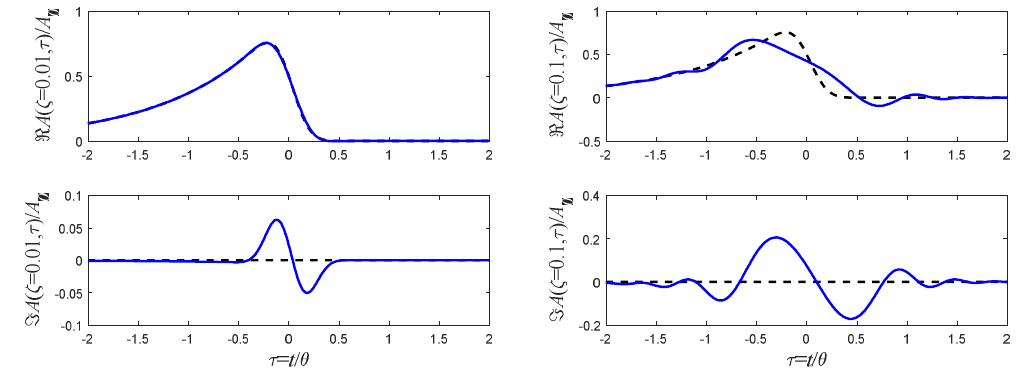
Figure 21. Same as Figure 10, but for Equation (77) with the transition width a = 1/ θ and ∆ = 0.2 θ for two final distances ζ = β 2 z / θ 2 = 0.01 on the left and ζ = β 2 z / θ 2 = 0.1 on the